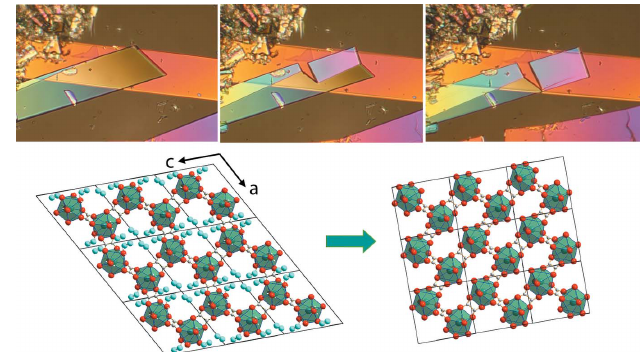
Figure 1 Schematic diagrams of the polarization rotation paths for Pb displace- ment vectors in the monoclinic mirror planes in the ( a ) M A / M B and ( b ) M C structures discussed in Zhang, Yokota et al. (2017). The large red atom at the centre of the unit cell is Pb, while the blue atoms are the surrounding O atoms of the PbO 12 cage. The small yellow atoms are the B -site cations Zr or Ti. Arrows indicate possible vector